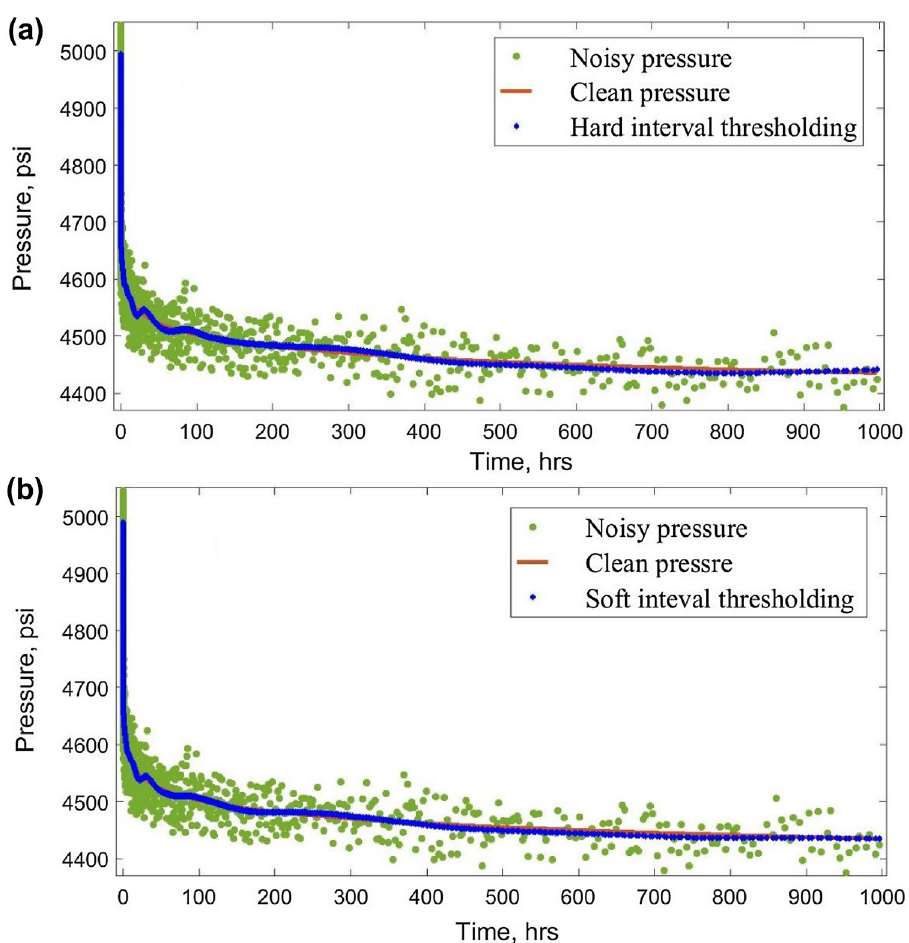
Fig. 8 Denoised signal for a